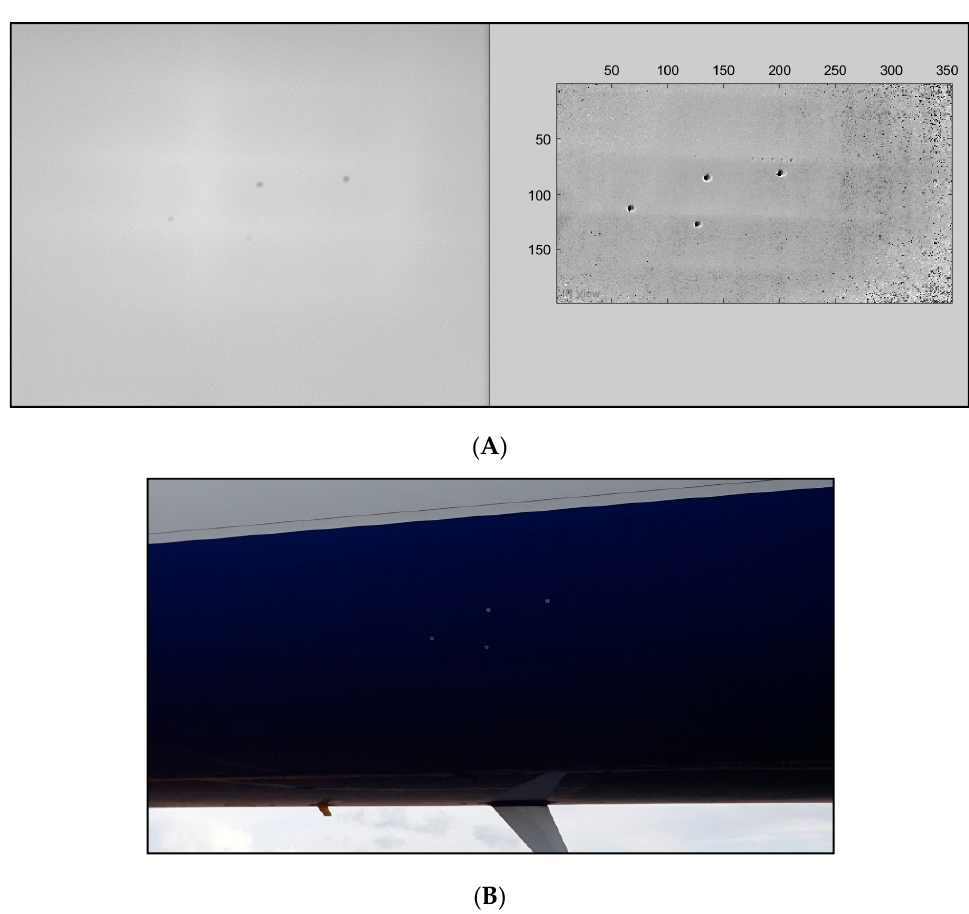
Figure 27. ( A ) Raw IR image of the B737 fuselage after signal processing. ( B ) RGB image of the B737 fuselage.